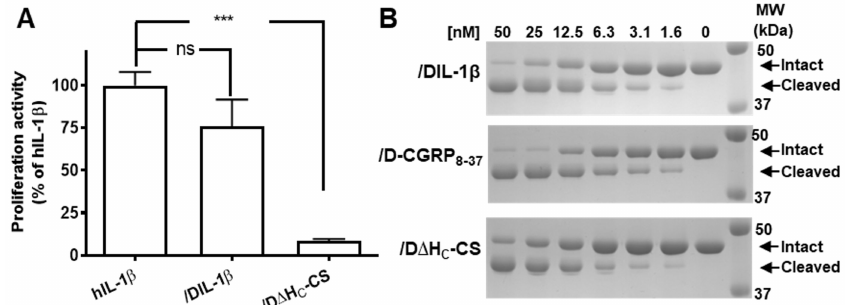
Figure 3. / DIL-1 β retains biological activities of its ligand and protease. ( A ) Bar chart showing RAW cell proliferation activity of / DIL-1 β and / D ∆ H C -CS relative to commercial human IL-1 β . Data plotted are mean ± S.E.M. ( n = 3). ns: non-significant, *** p < 0.001. ( B ) / DIL-1 β , / D-CGRP 8-37 and / D ∆ H C -CS have similar protease activities regarding cleaving a recombinant GFP-VAMP2 2-94 -His 6